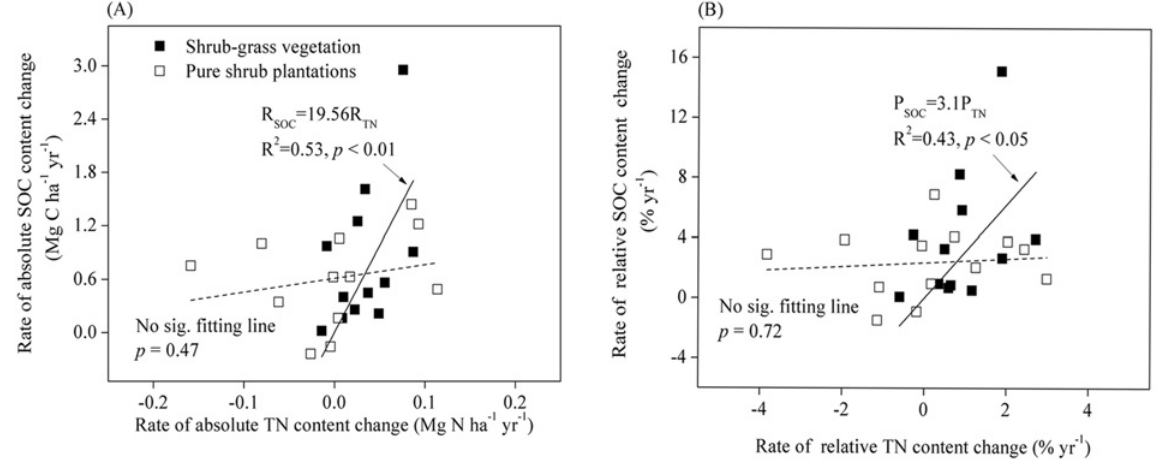
Fig 4. Patterns in SOC and TN content at 0 – 20 cm in shrub-dominated afforested sites. (A) Rates of absolute change in SOC and TN content; (B) Rates of relative change in SOC and TN content. The solid line indicates shrub-grass ecosystems and the dashed line indicates pure shrub plantations.